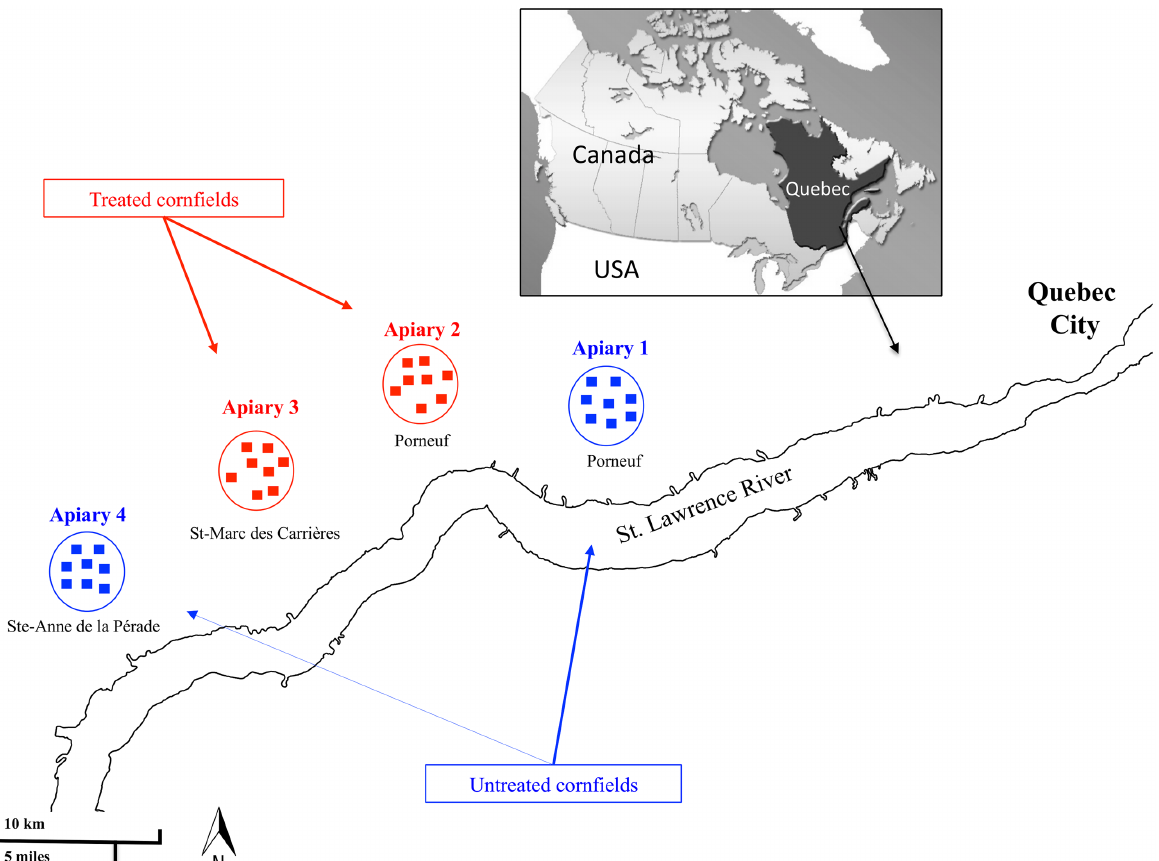
Fig 1. Location of the four honeybee apiaries southwest of Quebec City. Each apiary consisted of eight honeybee hives. Apiaries 1 and 4 (bleu color) are located in untreated cornfields while apiaries 2 and 3 (red color) are in fields sown with neonicotinoid treated seeds. Each square represents one honeybee